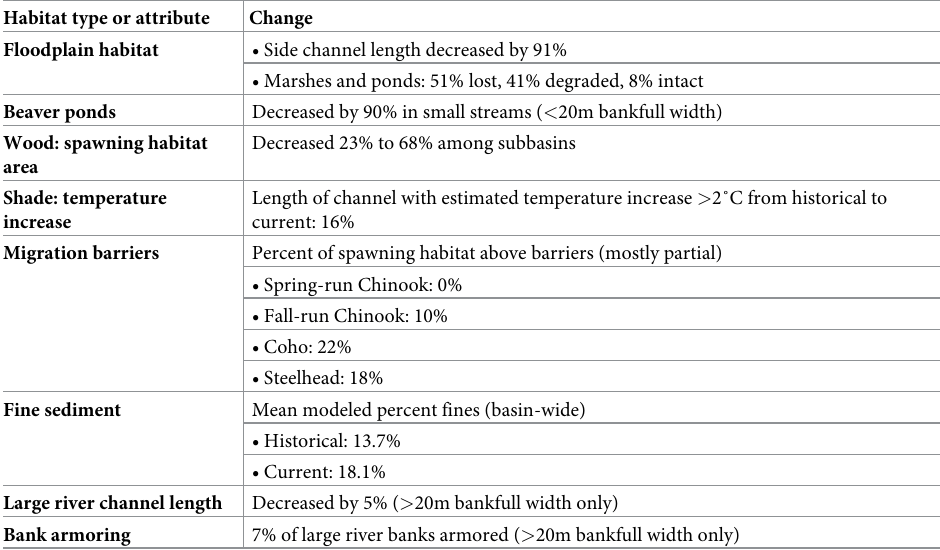
Table 3. Summary of habitat changes in the Chehalis River basin and Grays Harbor